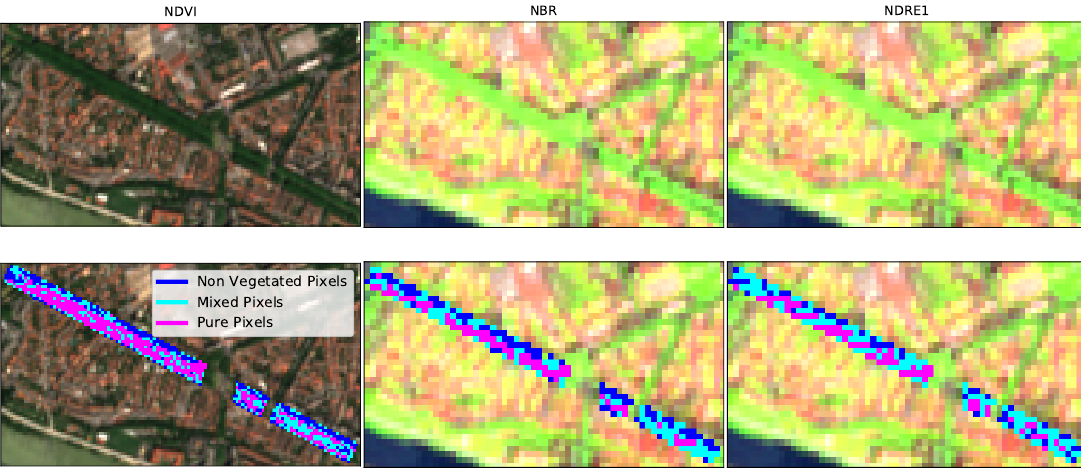
Figure 6. The 2018 London plane classification map obtained by applying the proposed methodology with NDVI ( left ) at 10 m resolution, Normalized Burn Ratio (NBR) (center) at 20 m resolution and Normalized Difference Red Edge Index 1 (NDRE1) ( right ) at 20 m resolution for Canal de Brienne area. Fuchsia indicates vegetation pixels, cyan indicates mixed pixels with an important quantity of vegetation while blue indicates non-vegetation pixels. Background are the RGB ( left ) and B6-B8A-B12 ( center and right ) composite Sentinel-2 images for 25th July